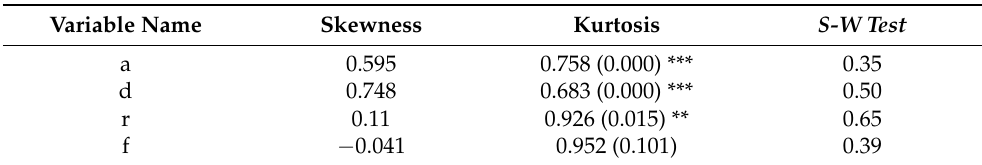
Table 4. Relevant mechanical indexes of concrete.